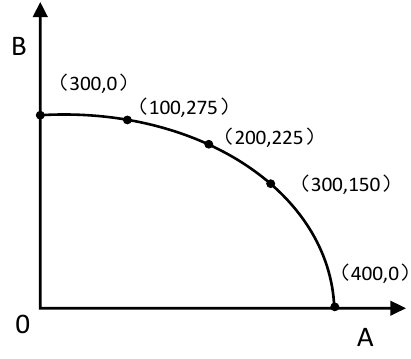
Figure 1. An example of a production possibility frontier curve for two products, A and B.